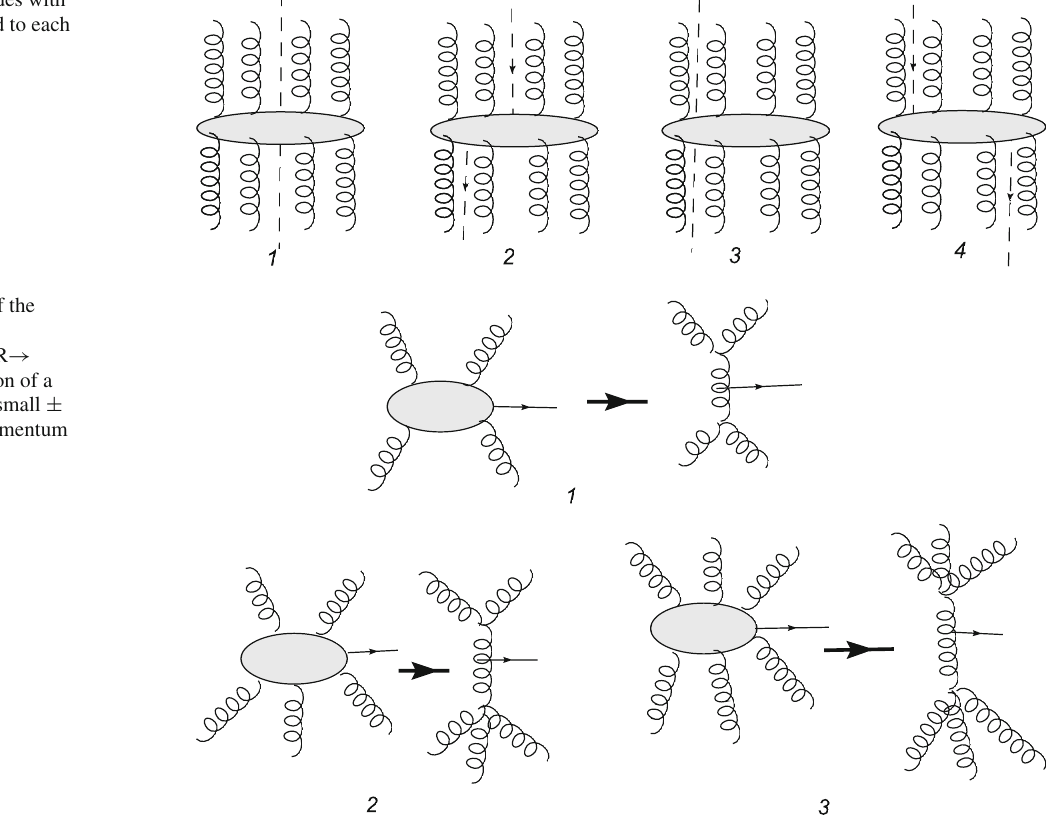
Fig. 11 Reduction of the vertices RR → RRG, RR → RRRG and RRR → RRRG for the emission of a particle (gluon) with small ± components of its